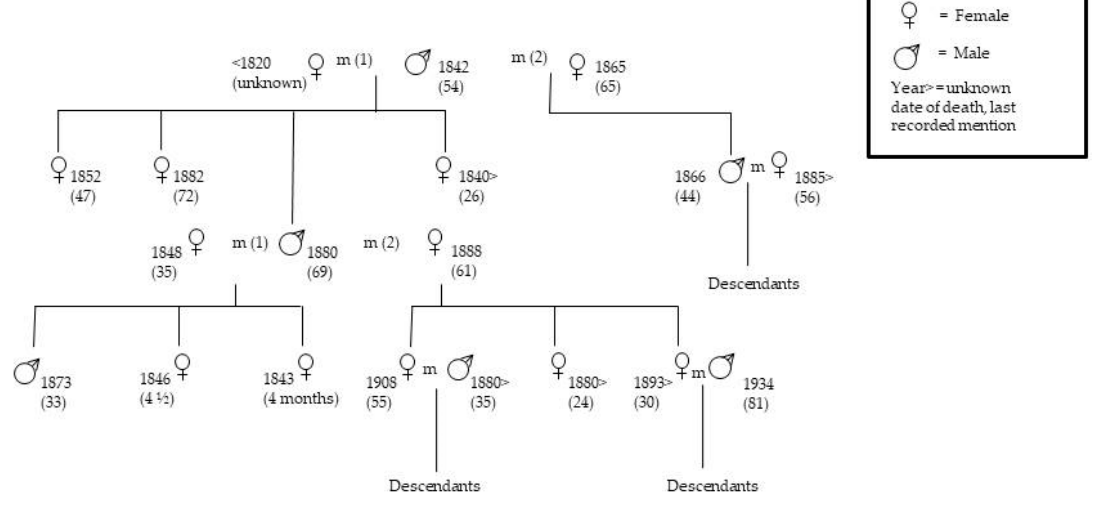
Figure 2. Familial genealogy: the Mønster family tree with gender, year and age at death in